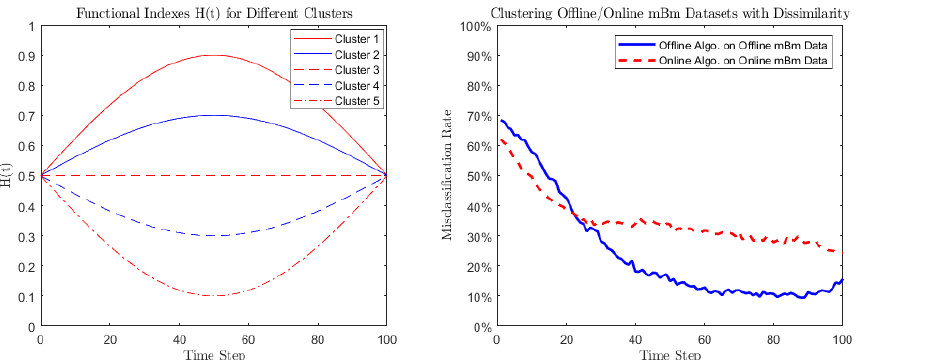
Figure 2. The functional form of H ( • ) follows Equation (74): H ( t ) = 0.5 + h i · sin ( π t /100 ) with t = 0,1, . . . ,100. The left graph plots H ( • ) corresponding to 5 different clusters. The right graph illustrates the misclassification rates output by (i) offline algorithm on offline dataset (solid line) and (ii) online algorithm on online dataset (dashed line). Both algorithms are performed based on the log ∗ - transformed covariance-based dissimilarity